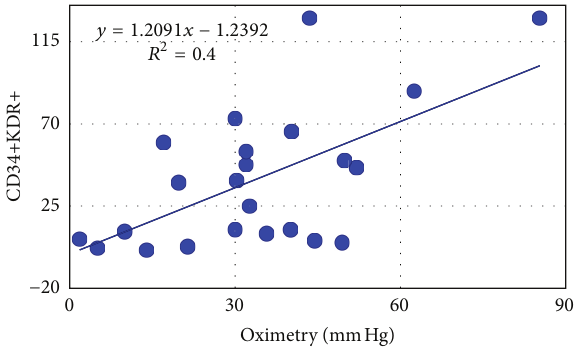
Figure 2: Relationships between CD34+KDR+ cells and skin foot released oxygen in type 2 diabetic neuroischemic subjects. Units for CD34+KDR+ are N cells/10 6